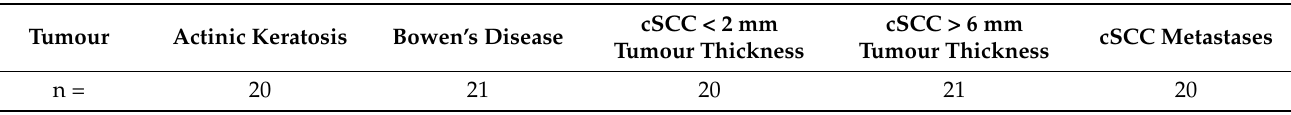
Table 1. One-hundred-and-two non-melanoma skin cancers located on the head and neck excised in non-immunosuppressed